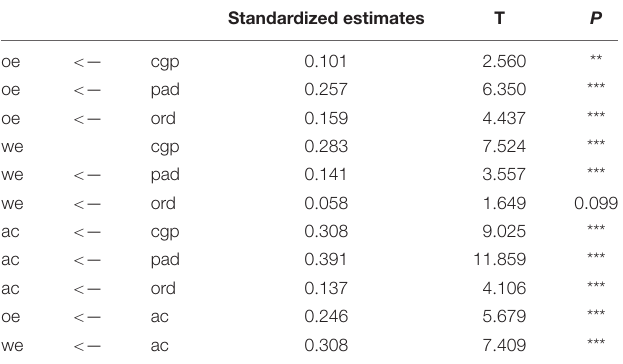
TABLE 4 | Moderated mediation effect